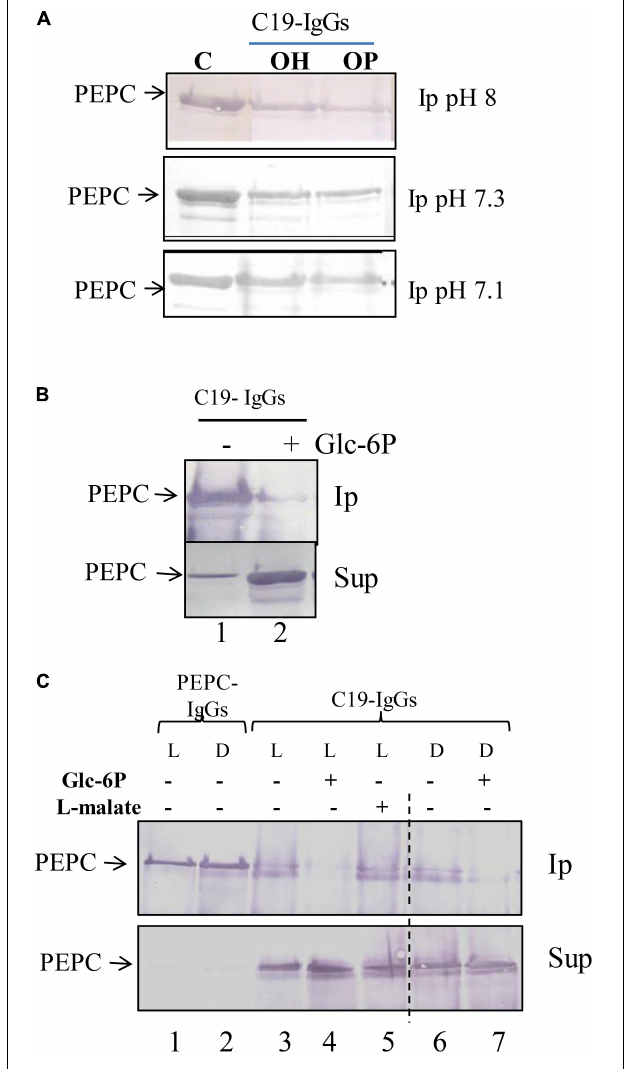
FIGURE 2 | Effect of pH, enzyme phosphorylation state and Glc-6P on the exposure of the C -terminus of C 4 -PEPC. (A) Phosphorylated (OP) or non-phosphorylated (OH) sp-PEPC were incubated in 0.1 M Tris–HCl buffer at different pHs (8, 7,3 or 7,1). Following 30 min at 30 ◦ C, PEPC was immunoprecipitated with C19-IgG. Lane C, sp-PEPC prior to immunoprecipitation. Phosphorylated PEPC was obtained by in vitro phosphorylation with PKA as described in M&M. (B) Non-phosphorylated PEPC incubated with 5 mM Glc-6P for 30 min and then immunoprecipitated with C19-IgG. (C) Clarified protein extract from illuminated (L, phosphorylated-PEPC) or dark (D, non-phosphorylated-PEPC) sorghum leaves incubated in the presence of Glc-6P or L-malate and immunoprecipitated with PEPC-IgG (lanes 1, 2) or C19-IgG (lanes 3–7). Protein was detected on immunoblots using PEPC-IgG. Ip, immunoprecipitated; Sup, supernatant. The enzyme phosphorylation state was controlled via the L-malate sensitivity test ( Table 1